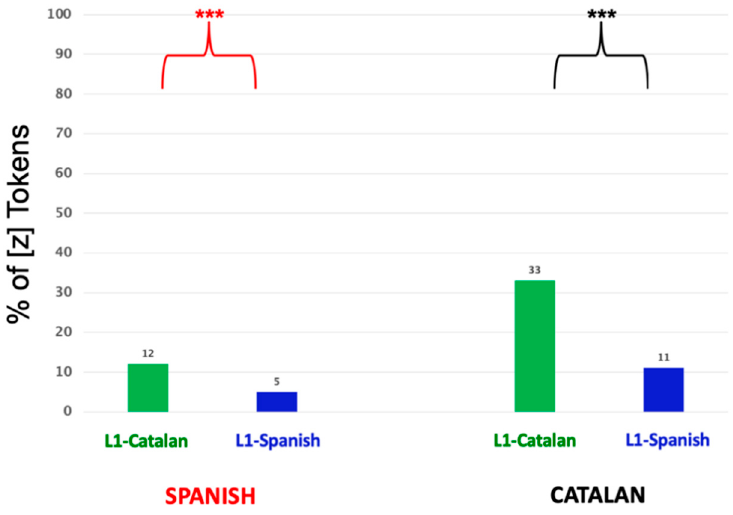
Figure 7. Effects of language profile and language on Valencian fricative production.